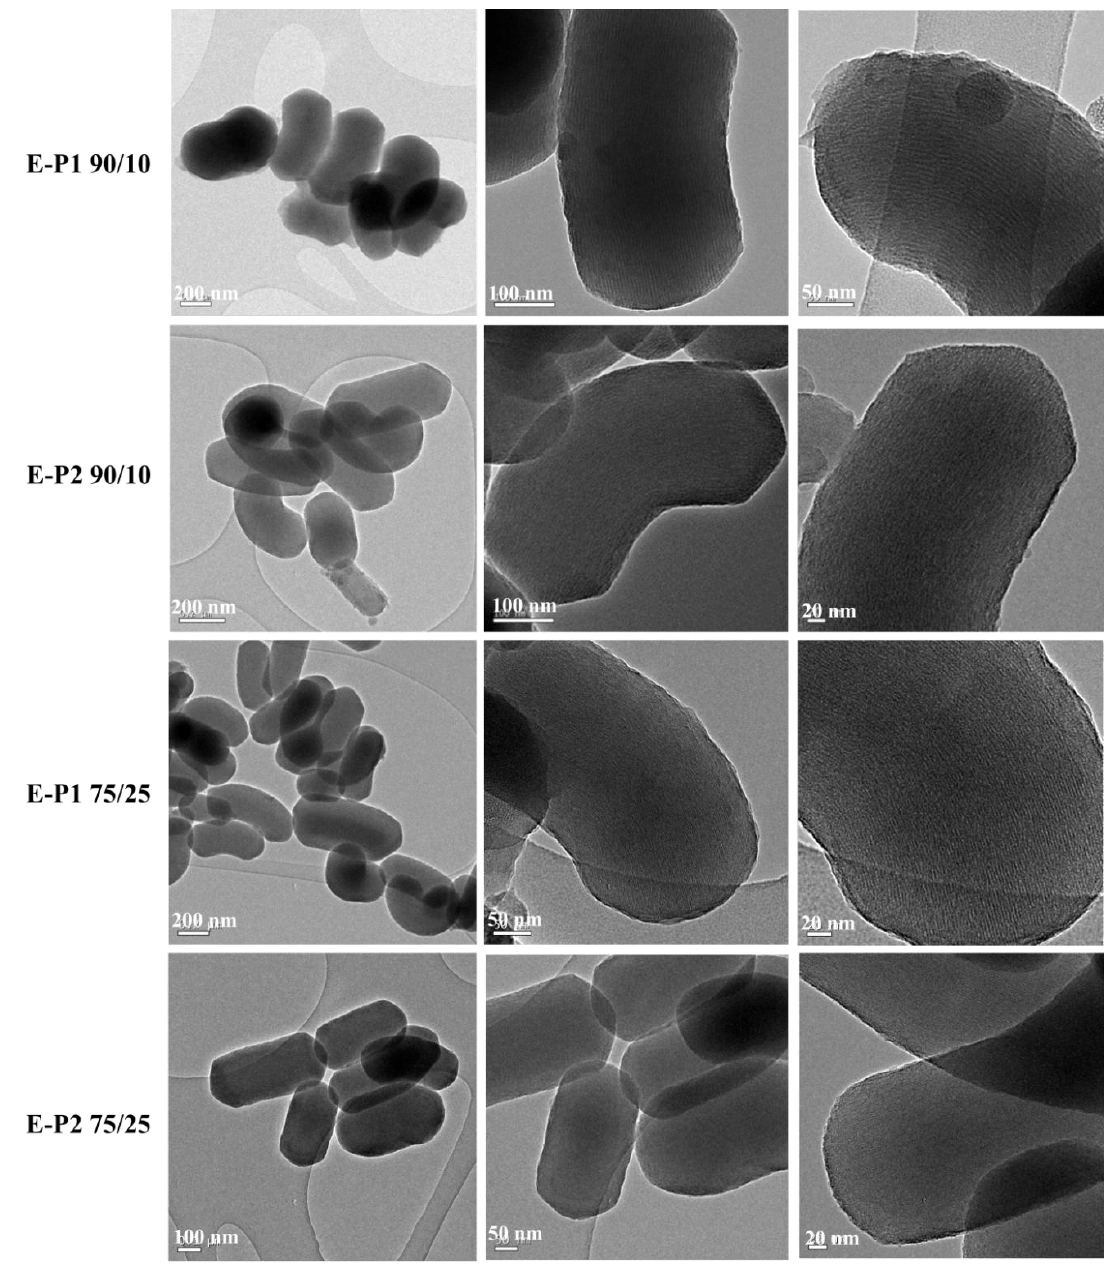
Figure 2. TEM images of E-Pn PMO NPs .